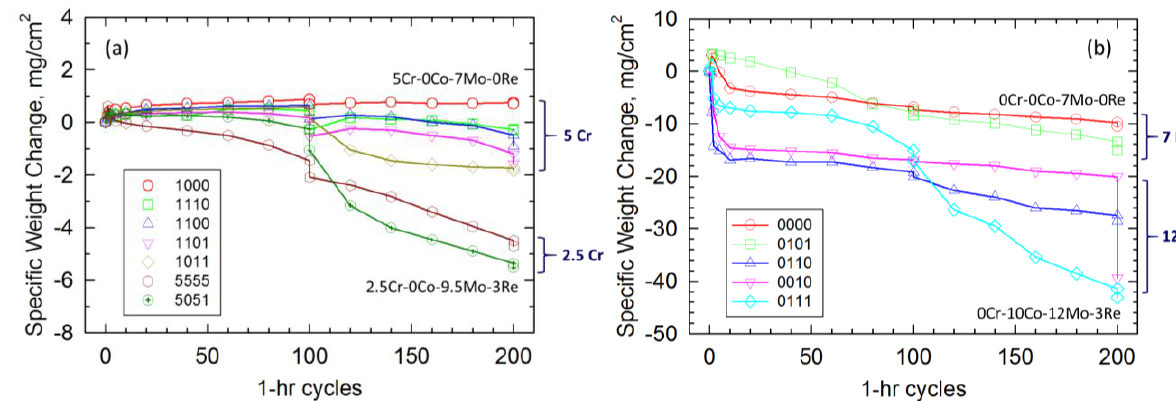
Figure 1. 1100 °C cyclic oxidation weight change for LDS VIM superalloys. (Cr, Co,